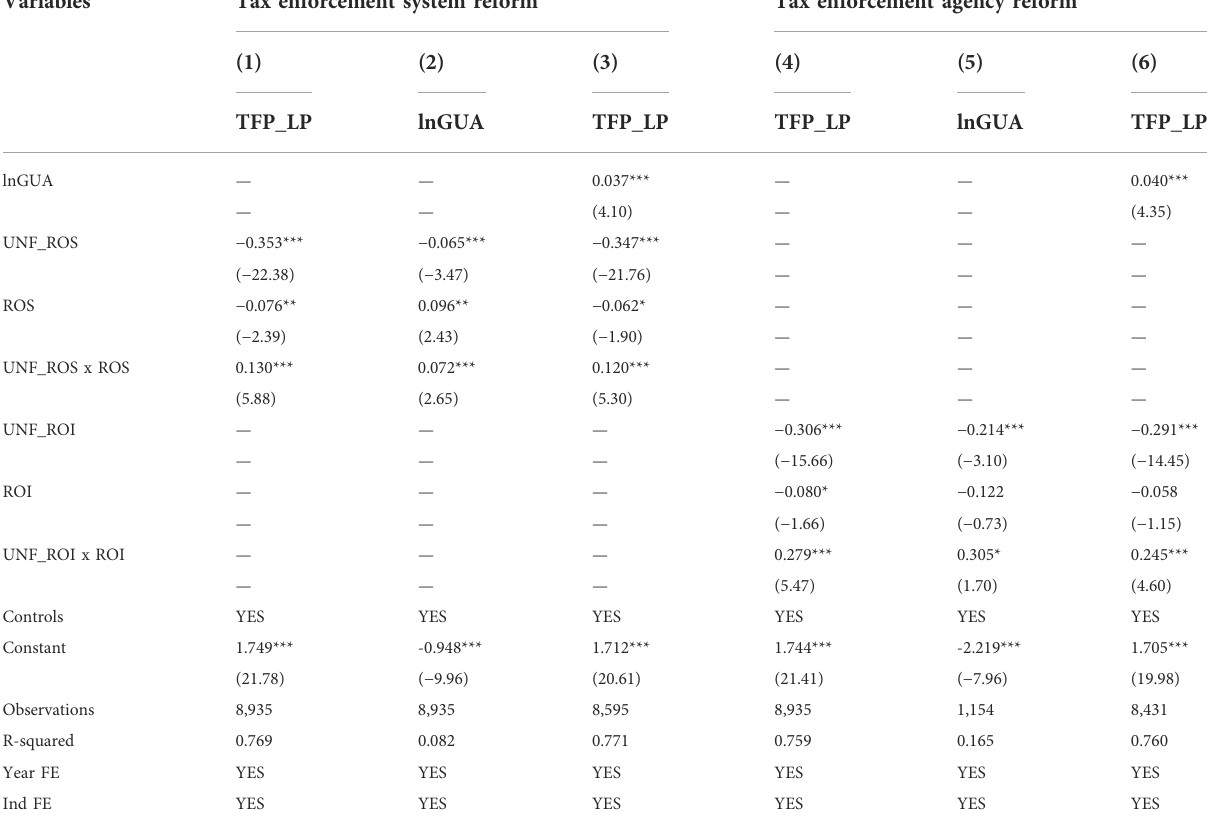
TABLE 12 Mediating mechanism of green utility model patent